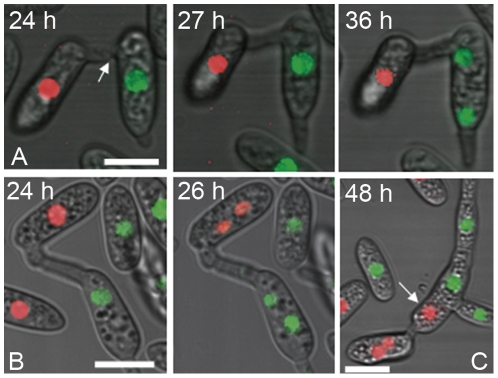
Time-lapse imaging of nuclear dynamics following CAT fusion between incompatible strains (tFI01 and tFI04).(A) CAT fusion was established (arrow at 24 h time point) and a germ tube started elongating from the base of the right conidium. Mitosis occurred in the right conidium between 27 and 36 h. (B) Following CAT fusion between uninucleate conidia (24 hrs), mitosis occurred after 2 h (26 h). (C) A nucleus (arrow) has migrated from one conidium to the other to form a heterokaryotic cell. Bar = 10 µm.